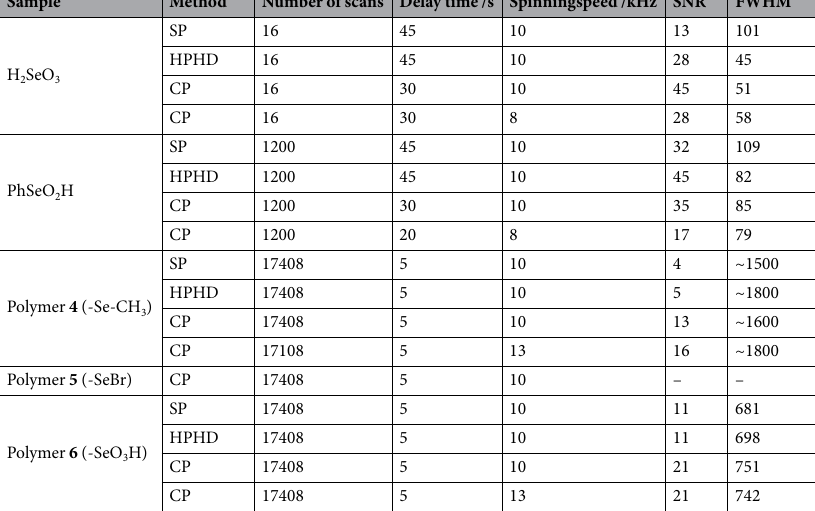
pulse sequencesas described in experimental section: single pulse (SP), high power 1 H decoupling (HPHD) and cross polarization (CP). To well illustrate the efficiency of the different methods, the intensity of the iso- tropic center-bands was normalized. A significant spinning side band manifold separated by the rotation fre- quency as a result of the chemical shift anisotropy (CSA) was observed in Fig. 2 left. The position of the isotropic center-bands ( * ) was determined by acquiring an additional spectrum at a different spinning speed of 8 kHz, which was enlarged in Fig. 2 right. The isotropic band remained at the same position for different speeds, while spinning side bands were changed (dashed lines, Fig. 2). Application of both HPHD and CP could enhance rela- tive intensity of the resonance peak and narrow the lines (Fig. 2). An asymmetric isotropic band was observed for HPHD and CP, which might be related to defect in H 2 SeO 3 crystal 49 . The chemical shift obtained by SP sequence was chosen to be the reference standard (1288.1 ppm). Full Width at Half Maxima (FWHM) and the SNR of the isotropic band were obtained and listed in Table 1. The SNR was improved from 13 for SP to 28 for HPHD and to 45 for CP, and the corresponding FWHM decreased from 101 Hz to 45 Hz and to 51 Hz. The existence of abundant 1 H would broaden the line of 77 Se spectra due to heteronuclear dipolar coupling between 1 H and 77 Se,